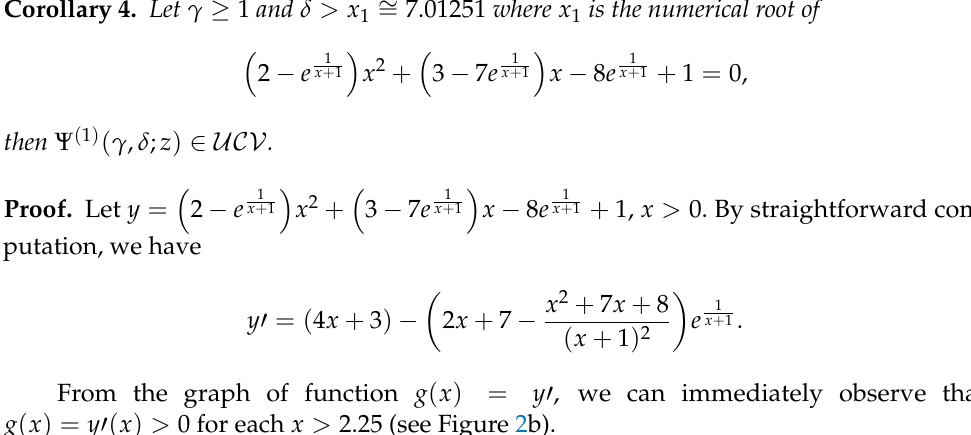
Figure 1. The graph of the function: ( a ) f ( x ) = y = (cid:16) (cid:17) e 1 x + 1 . 2 − 1 − x + 3 ( x + 1 ) 2 Thus, y ( x ) is an increasing function for x > 0.